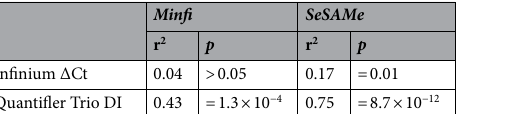
Table 1. Correlation coefficients (r 2 ) between probe DR and Infinium QC ΔCt and Quantifiler Trio